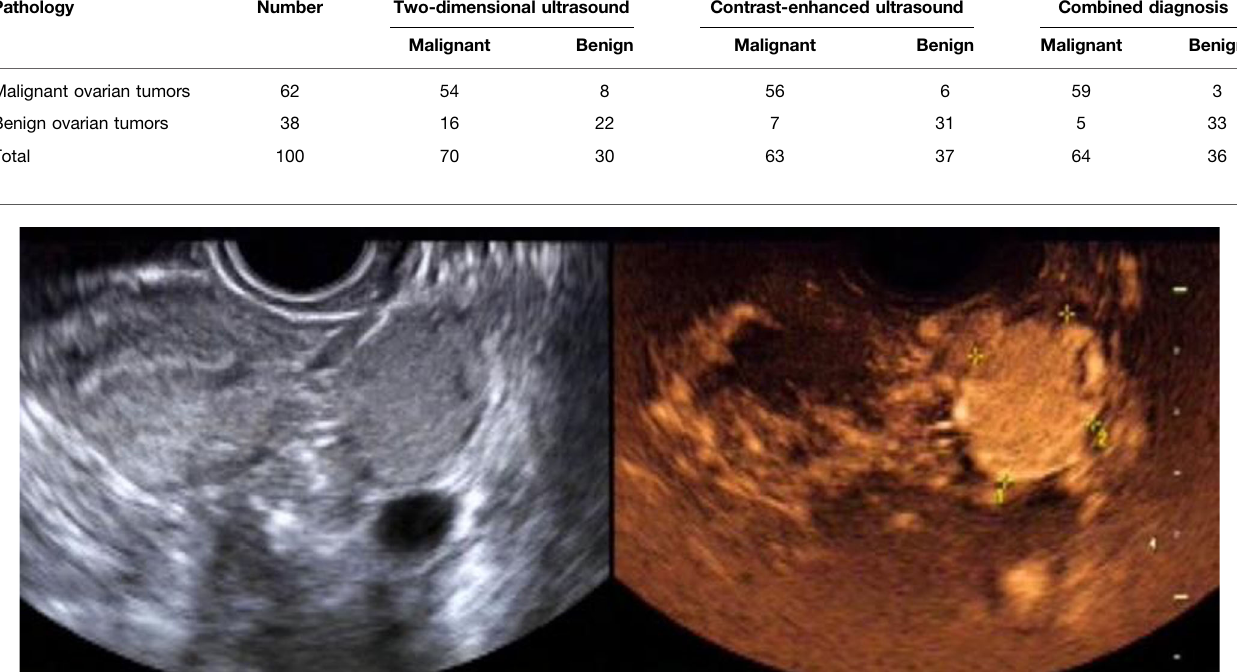
TABLE 2 | Comparison of diagnostic results between two-dimensional ultrasound and contrast-enhanced ultrasound. Pathology